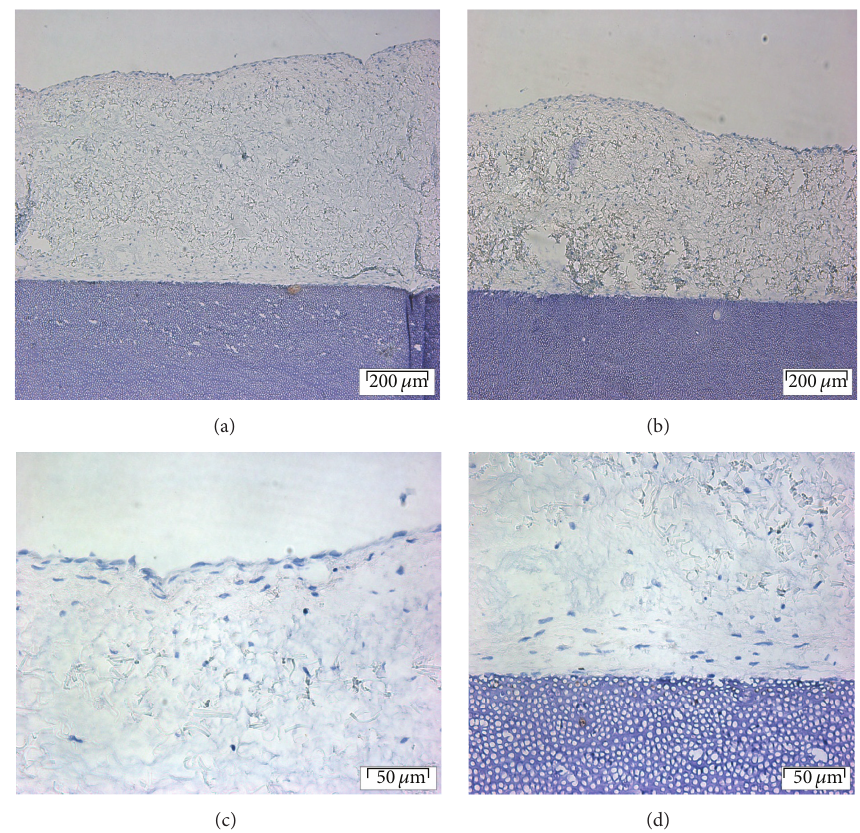
Figure 6: CAP expression in spheroids-collagen-dentin complex: (a) an overview of collagen and dentin, (b) negative control, (c) a closer view of the surface of collagen, and (d) a closer view of collagen and dentin junction. Scale bar of (a) and (b) = 200 𝜇 m, magnification: × 10; (c) and (d) = 50 𝜇 m, magnification ×